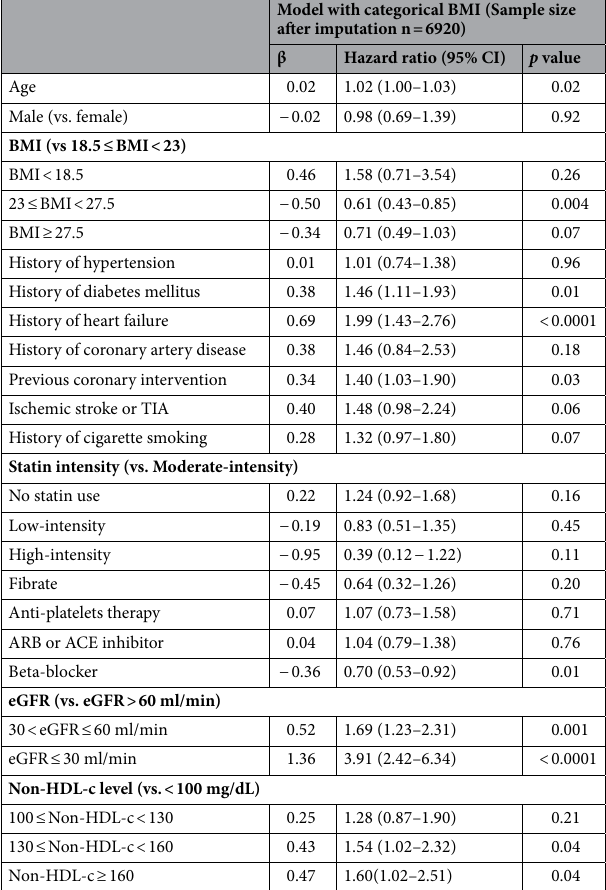
Table 3. Multiple Cox proportional hazards regression model for categorical BMI to predict the risk of MACE in ASCVD patients. ACE Angiotensin-converting enzyme, ARB Angiotensin II receptor blocker, BMI Body mass index, eGFR Estimated glomerular filtration rate, HDL-C High-density lipoprotein cholesterol, TIA Transient ischemic attack.